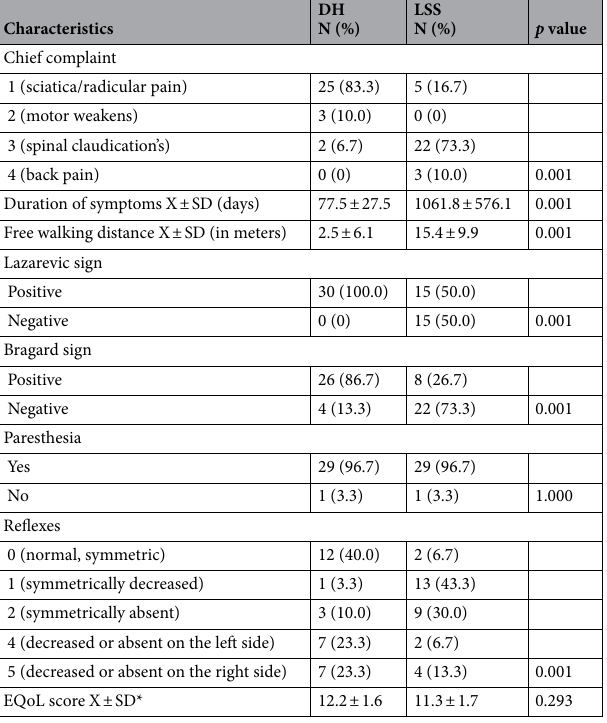
Table 2. Clinical sign and symptoms of patients included in the study. *EQoL score is an instrument which evaluates the generic quality of life developed in Europe and widely used 10 .